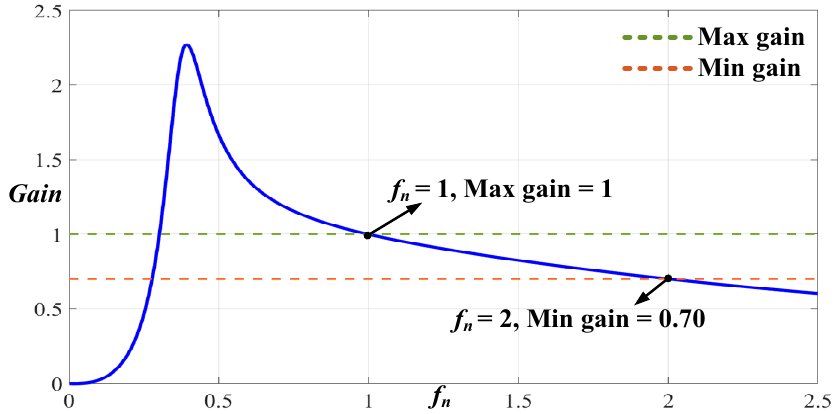
Figure 12. Voltage gain curve of the 2C3L resonant circuit in G2V mode.